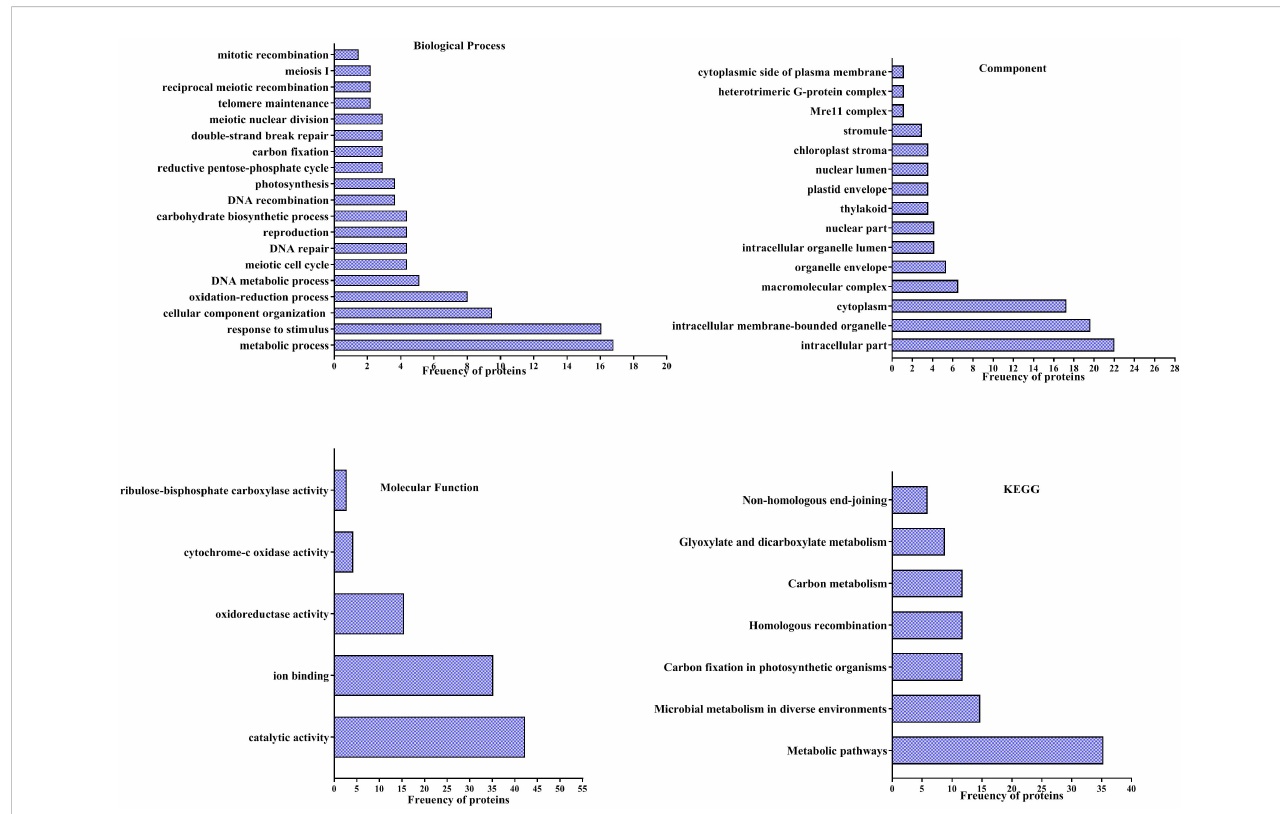
FIGURE 5 Analysis of Gene ontology (GO) of differentially accumulation proteins of pistachio leaves under osmotic condition. Pathways of four groups of functional enrichment consisting of biological process, cellular component, molecular function and KEGG were analyzed via the STITCH database.